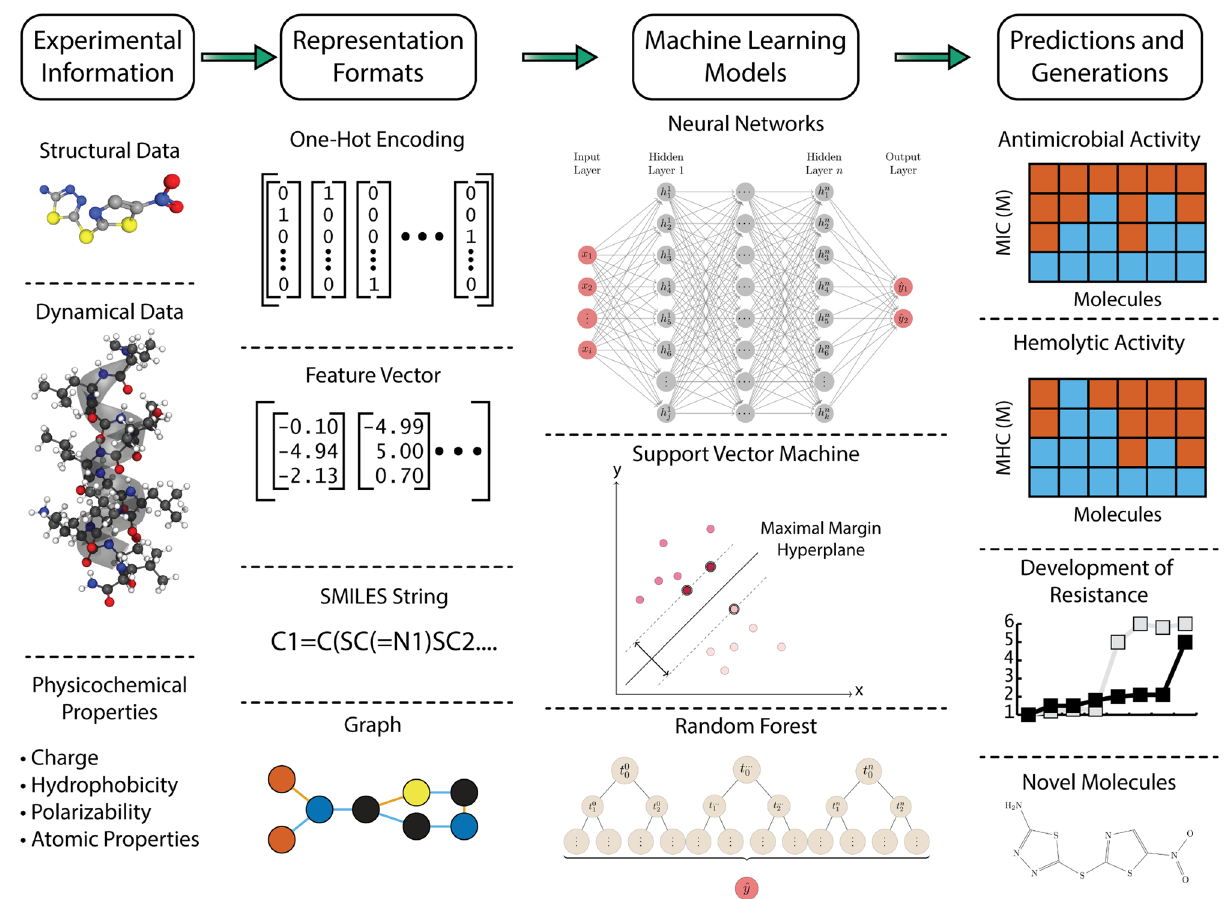
Fig. 1 Computational antibiotic discovery pipeline. The fi gure provides an overview of data and methods used in antibiotic discovery and development using AI. From left to right, key elements in the drug development process are exempli fi ed. The fi rst part of any AI-driven project is gathering the experimental information that will enable model creation. The data are then transformed into AI-ready representations. Subsequently, models are trained using algorithms that can range from traditional decision trees to novel neural networks. Finally, trained models can be used to predict diverse qualities, e.g., the effectiveness of an antibiotic, potential for toxic activity, development of resistance, or the structure of novel compounds that exhibit desirable